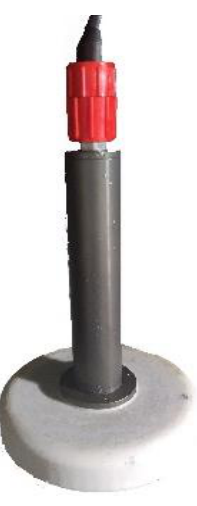
Figure 9. Absorber object.